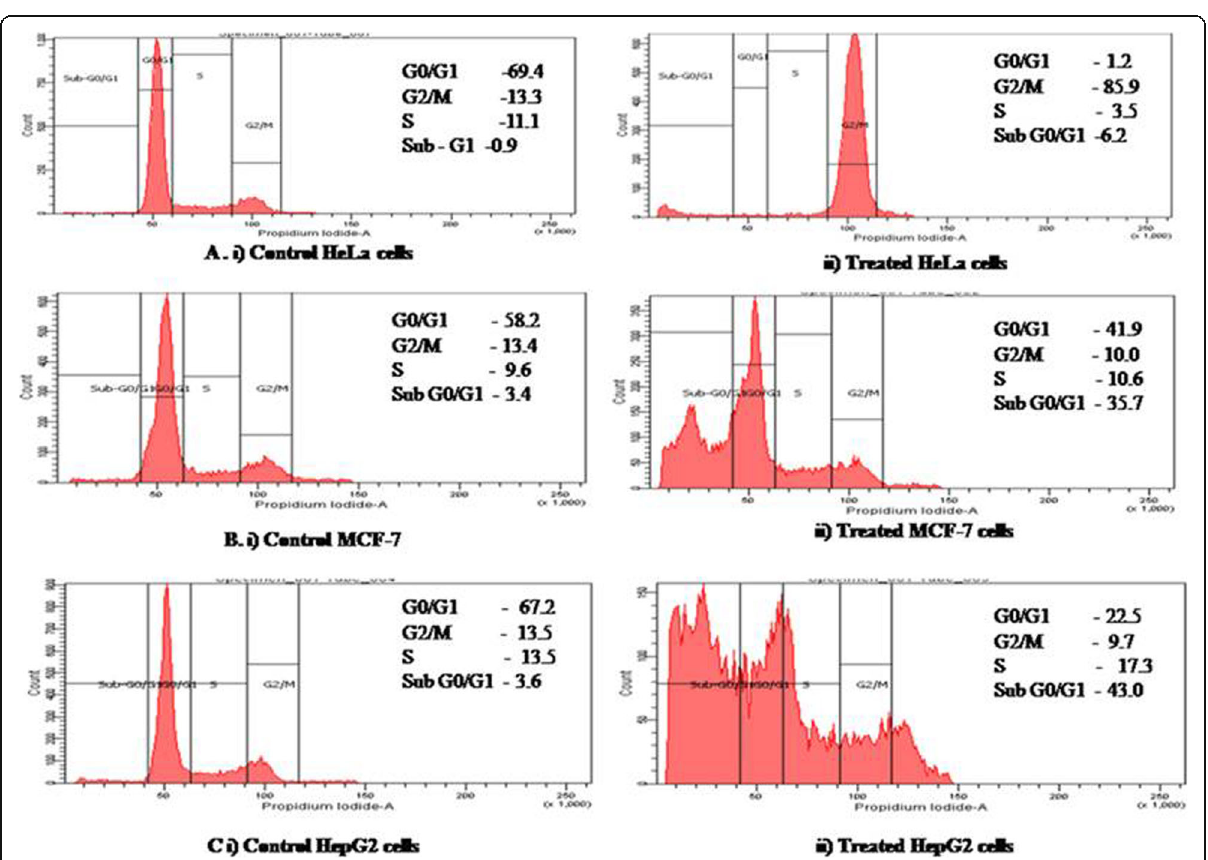
Fig. 8 Flow cytometry analysis of cell cycle by PI staining. a (i) Control HeLa cells and (ii) treated HeLa cells. b (i) Control MCF-7 cells and (ii) treated MCF-7 cells. c (i) Control HepG2 cells and (ii) treated HepG2